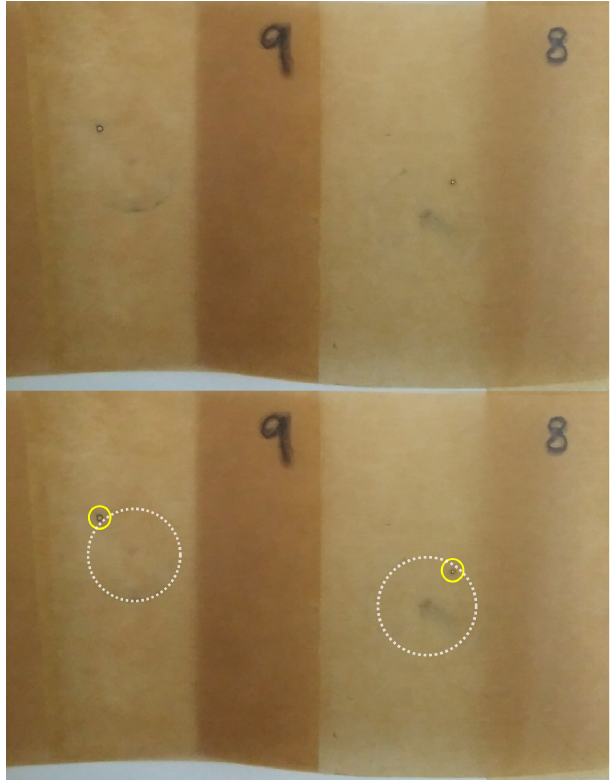
Figure 10. Image of two samples after the